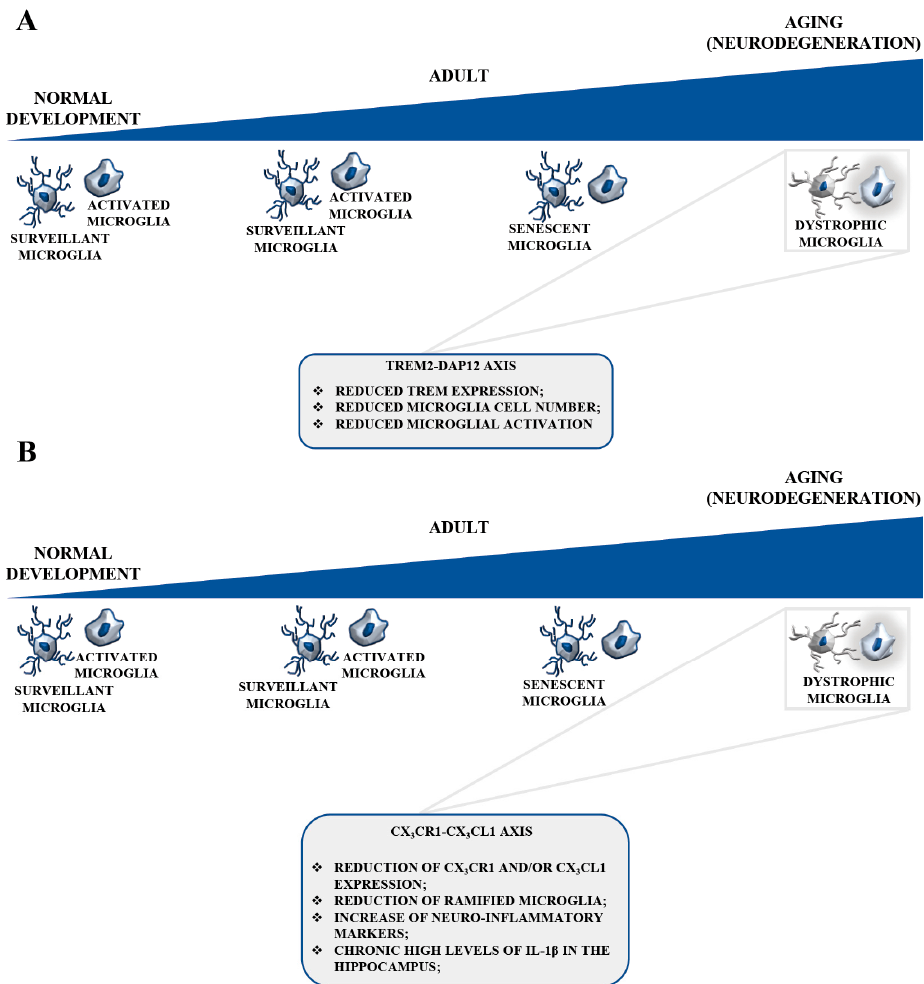
Figure 3. TREM2-DAP12 and CX3CL1-CX3CR1 signaling in aged microglia. ( A ) TREM2 expression is reduced in aged mice. A progressive decline in TREM2 expression might occur during aging in certain areas of the human brain, reducing microglial cell numbers and the microglial response to the breakdown of astrocytes, oligodendrocytes, neurons, and myelin. These events would create a fertile ground for neurodegeneration. TREM2 deficiency hinders the accumulation of microglia during aging. ( B ) CX3CL1 expression levels physiologically decrease in aged rodents which show a reduction of ramified microglia and a rise of neuroinflammatory markers. Reduced levels of CX3CL1 and CX3CR1 in the aged brain greatly alter the overall functionality of this pathway, with morphological and functionally impaired microglia. During aging, reduced neurogenesis occurs in the hippocampus. The pharmacological knockout or genetic deletion of CX3CR1 lead to decreased neurogenesis in the dentate gyrus of the mouse hippocampus, with an IL-1 β -dependent decline of both the survival and the proliferation rate of the neuronal progenitors. The physiological decline in neuronal CX3CL1 might contribute to increased microglia activation.